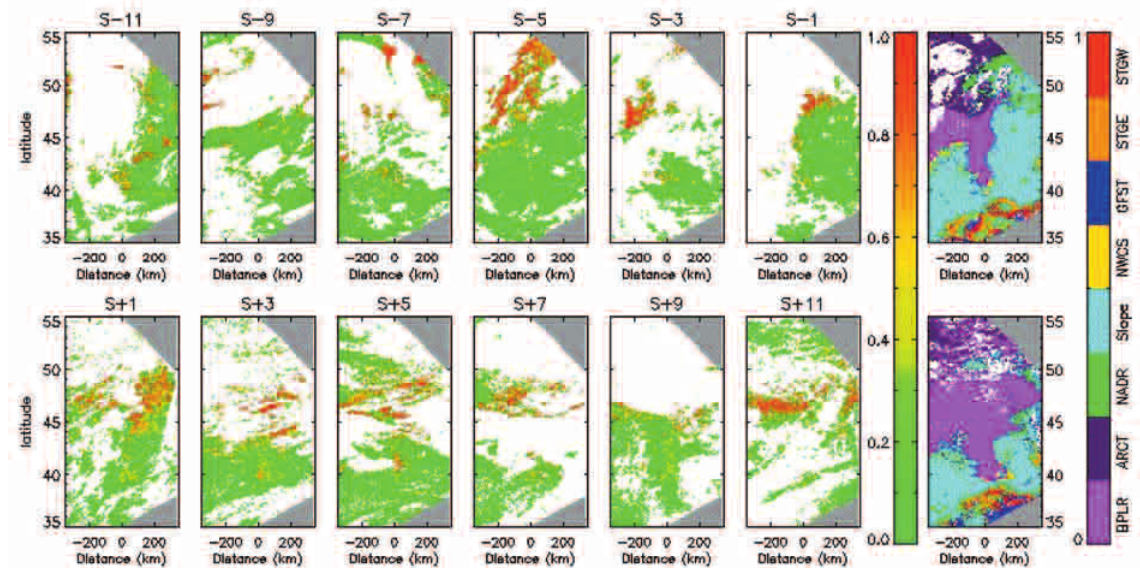
Fig. 16. – Temporal series of two-day composite images of the probability of occurrence of a diatom-dominated population along the storm track 12 days before (top) and 12 days after (bottom) the passage of the hurricane. Data were averaged across the storm track within a 700 km band (see Fig. 12). Plots on the right-hand side indicates the biogeochemical provinces before and after the